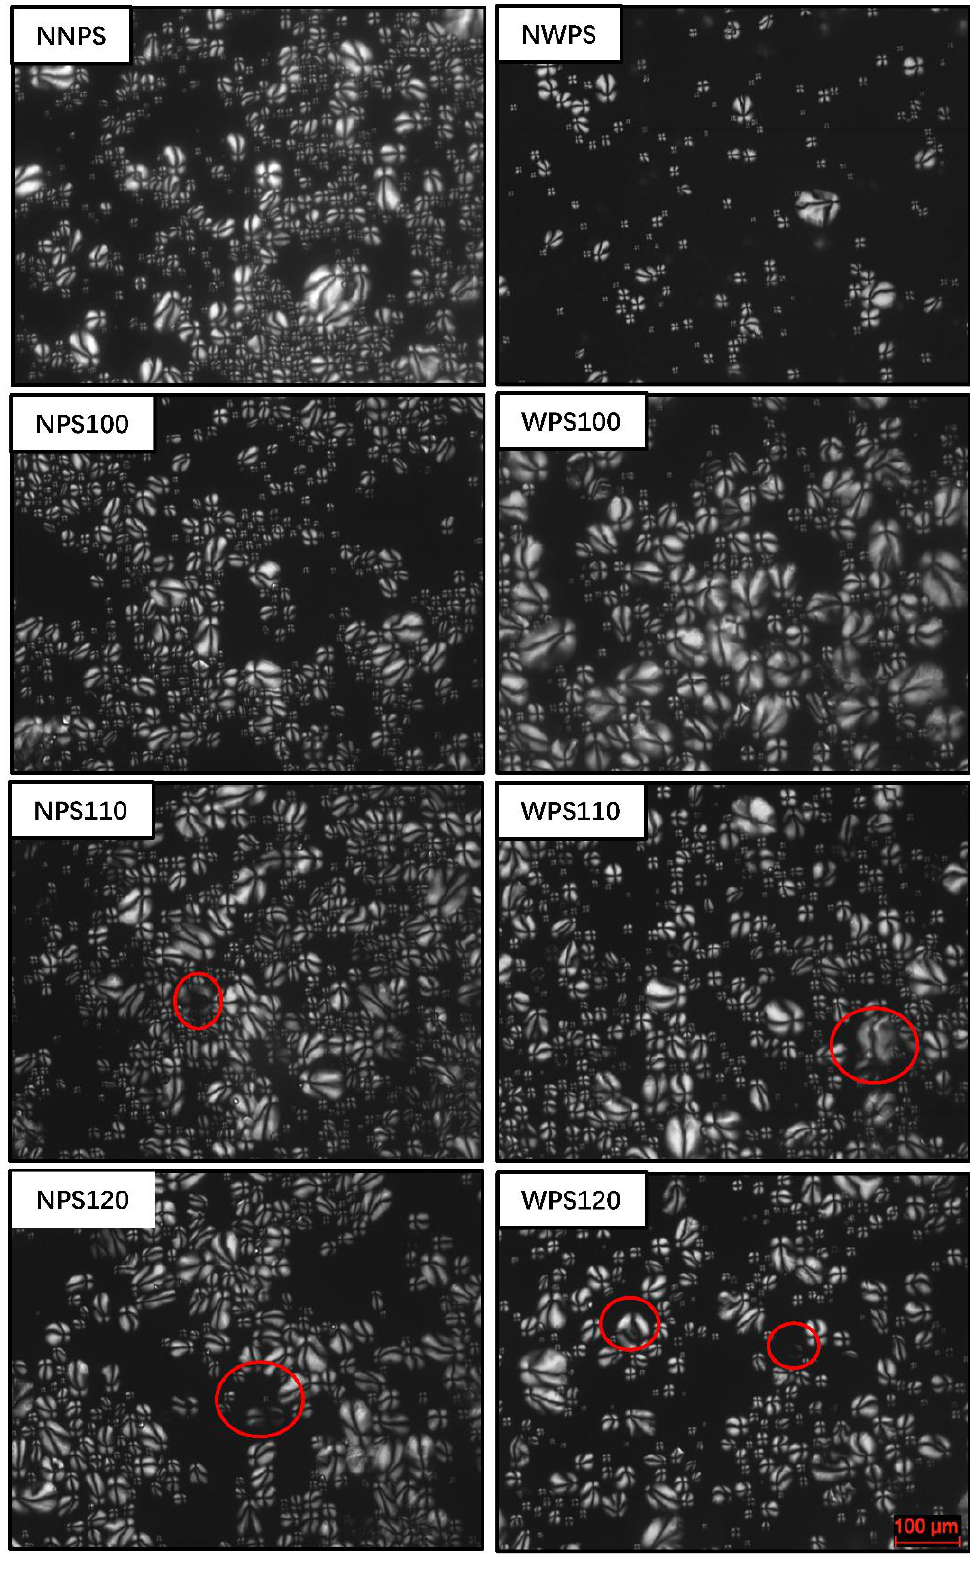
Figure 2. Polarized light microscopy of the samples (200×) (Red circles were indicated change in light refracted by the particles).